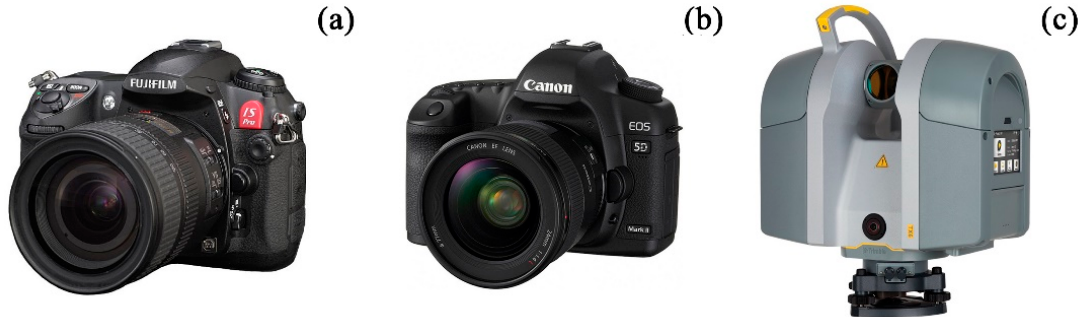
Figure 2. ( a ) Fuji IS Pro; ( b ) Canon EOS 5D Mark II; ( c ) Trimble